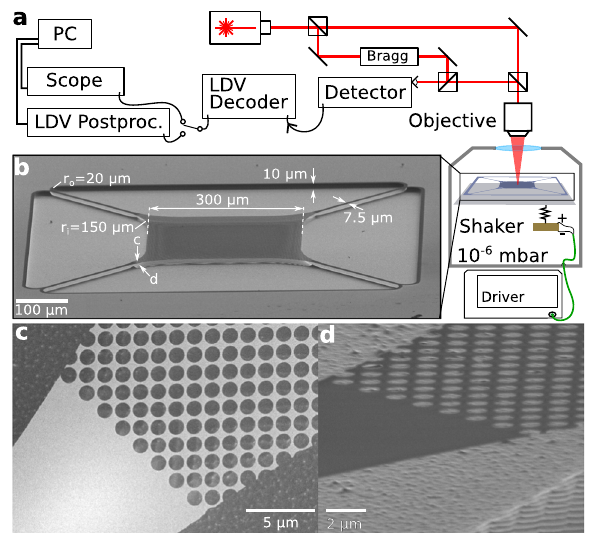
Fig.5|Setupandmembranes.a SchematicofthelaserDopplervibrometer(LDV) setup, where we access the chip containing the membranes using a microscope objective directly outside a vacuum chamber. b SEM image of the suspended membrane, with nominal design parametersin white. c Top-down view of a corner ofthemembrane,highlightingtheinterfaceofthephotoniccrystalwiththetether. d TiltedviewtoshowSisurfacebelow c ,toillustrateetchroughnessandanetched imprint of the photonic crystal pattern (bottom